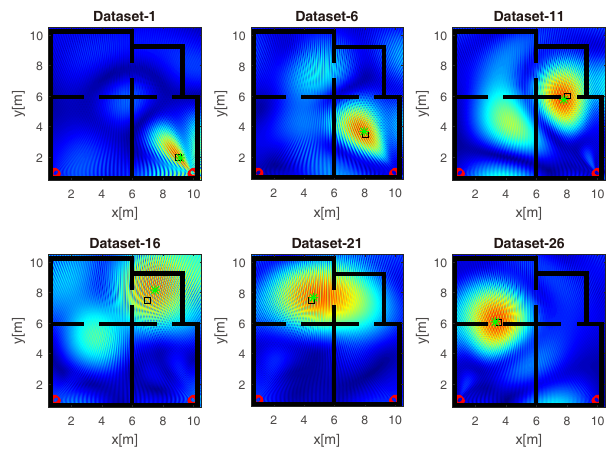
Figure 12. Tomographic images of a narrow band source achieved with array data fusion (C). Arrays (red circles); true source position (black square); estimated source position (green asterisk). Color scale is [0, 1].